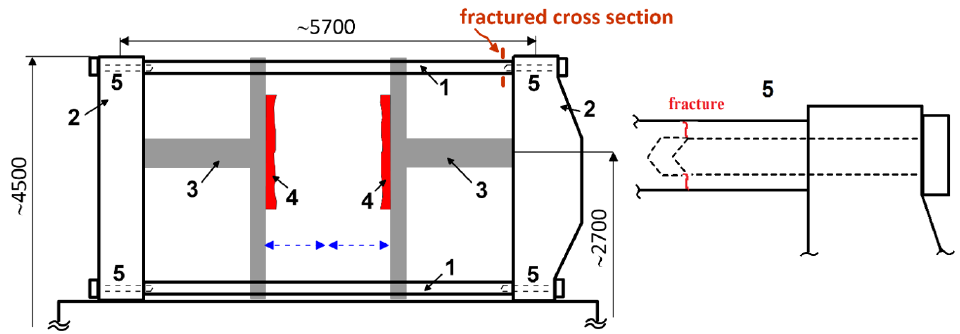
Figure 1. Scheme of the main frame of the pressing machine for production of car tanks. 1—guide bars, 2—massive stiff vertical frame members, 3—hydro motor, 4—former, 5—M80 bolts (detail), l ≈ 520